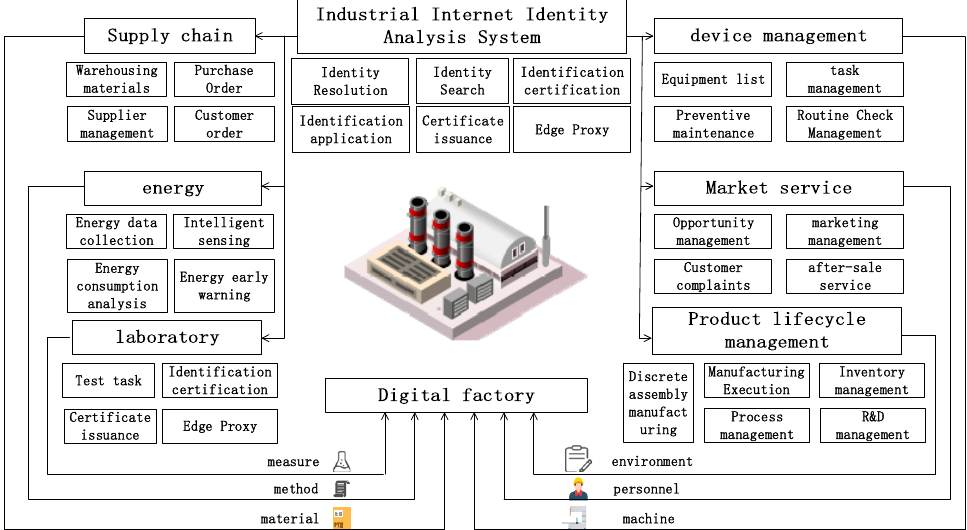
Figure 4. Identity resolution for full connection digital factory applications.